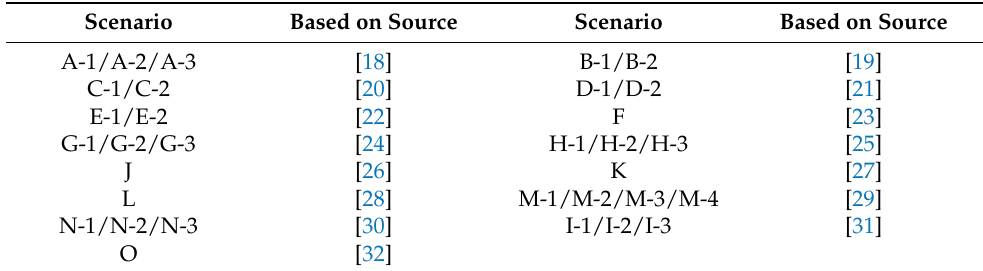
Table 1. Researched scenarios for the development of electric vehicles.